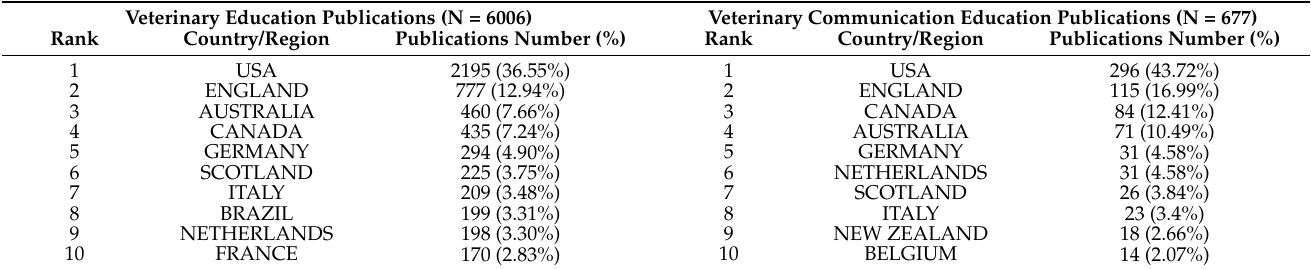
Table 5. The top 10 productive countries for veterinary education publications (VEPs) and veterinary communication education publications (VCEPs) from 2000 to 2021.